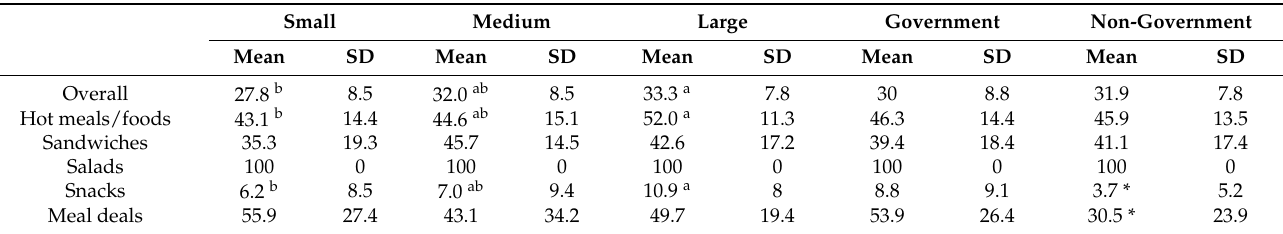
Table 2. Mean (and standard deviation, SD) proportions of items with vegetables (%) within each menu category split for school size ( ≤ 400 students = small; 401–600 students = medium; >600 students = large) and school type (government and